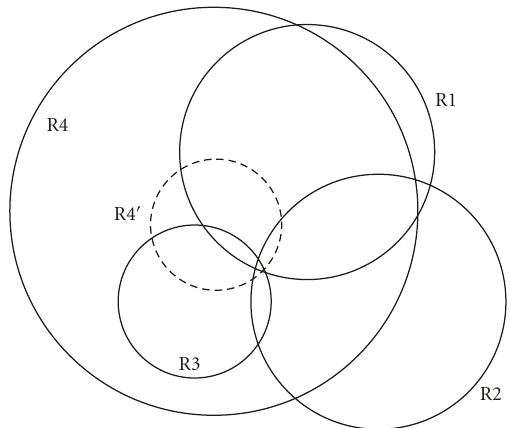
Figure 3: Demonstration of the special situation. The solid circles are created based on the range estimates and the dashed circle R4 (cid:4) is produced based on the true distance between the target node and reference node R4. In this case, there are two subgroups, (R1, R2, and R3) and (R1, R2, and R4), with MSE of the range estimated smaller than the variance of LOS range